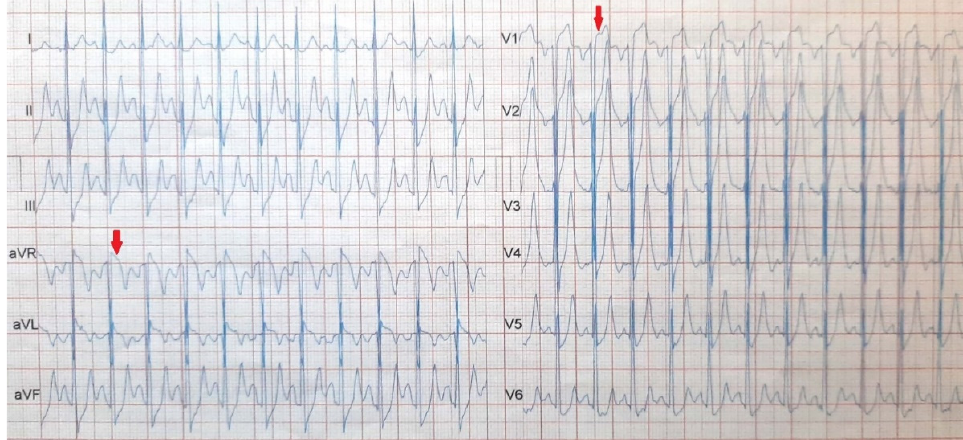
Figure 1. Bruce stress test: at 8 min and 20 s. During the 3rd stage, the test was stopped due to angina and the electrocardiogram (ECG) findings at 150 bpm showed diffuse ST-segment depression and ST-segment elevation in aVR and V1 > 3 mm.